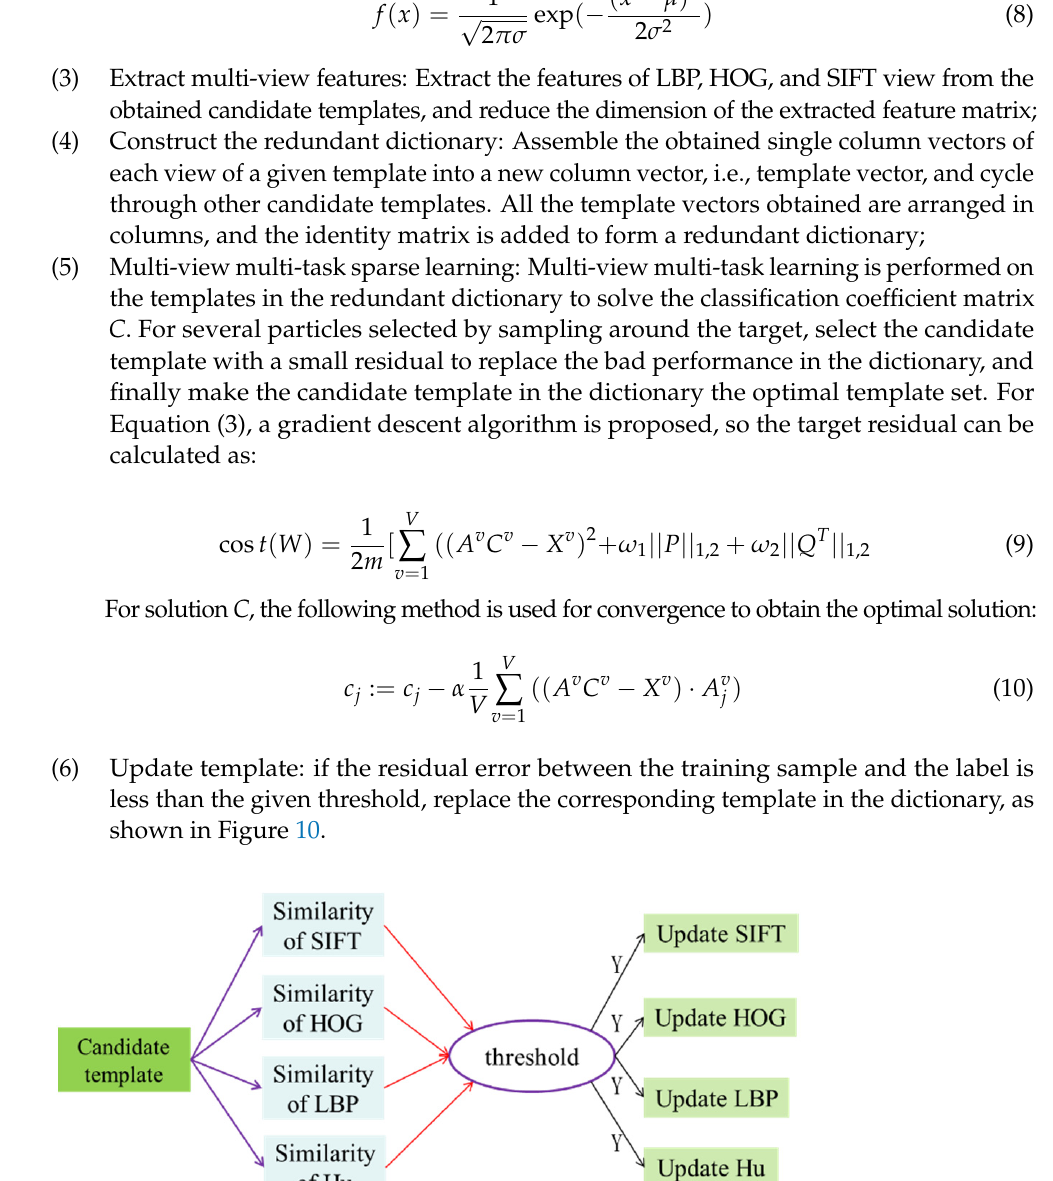
dictionary, and Y represents the label. The flow chart of target judgment is shown in Figure